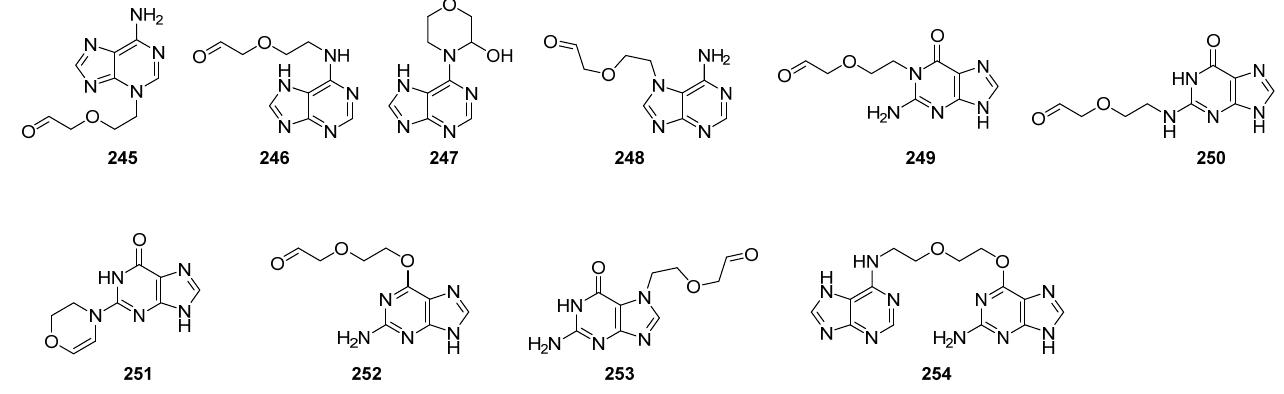
Figure 15. Structures of DNA adducts formed by NMOR metabolism.